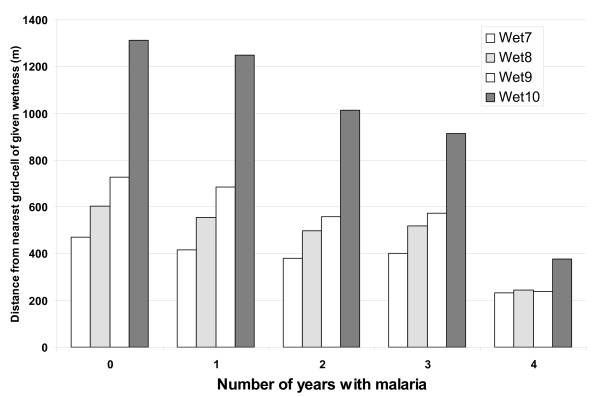
Predicted wetness for houses with recurrent malaria. Distribution of distances to the nearest cell in the four highest wetness categories for Kipsamoite houses with malaria cases in 0, 1, 2, 3, or 4 years. Increasing numbers of years are significantly associated with closer proximity to all four categories.